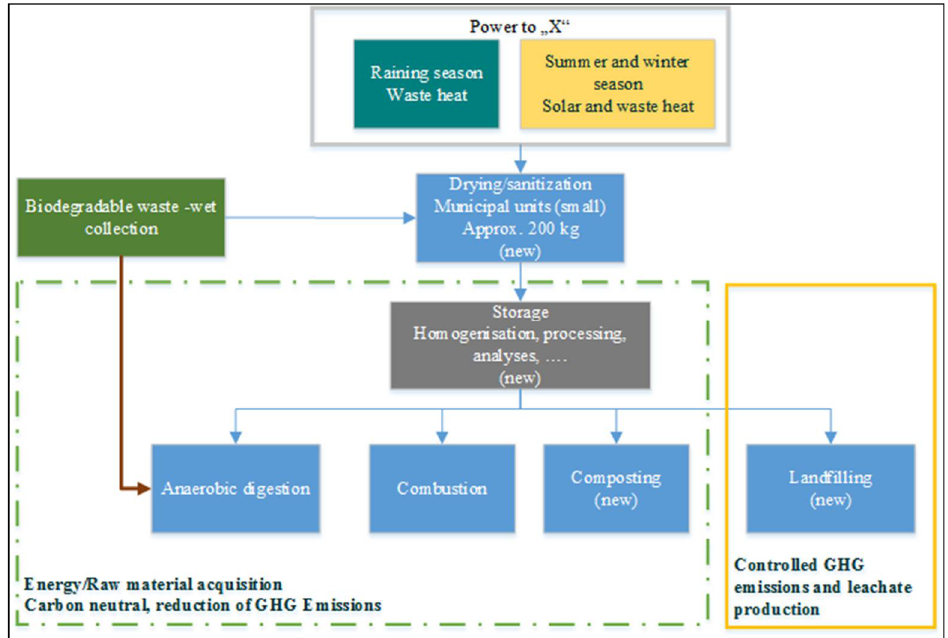
Figure 12. A sustainable approach to waste management for a sustainable energy system in Myanmar: (new) refers to the proposed pretreatment/waste disposal methods.